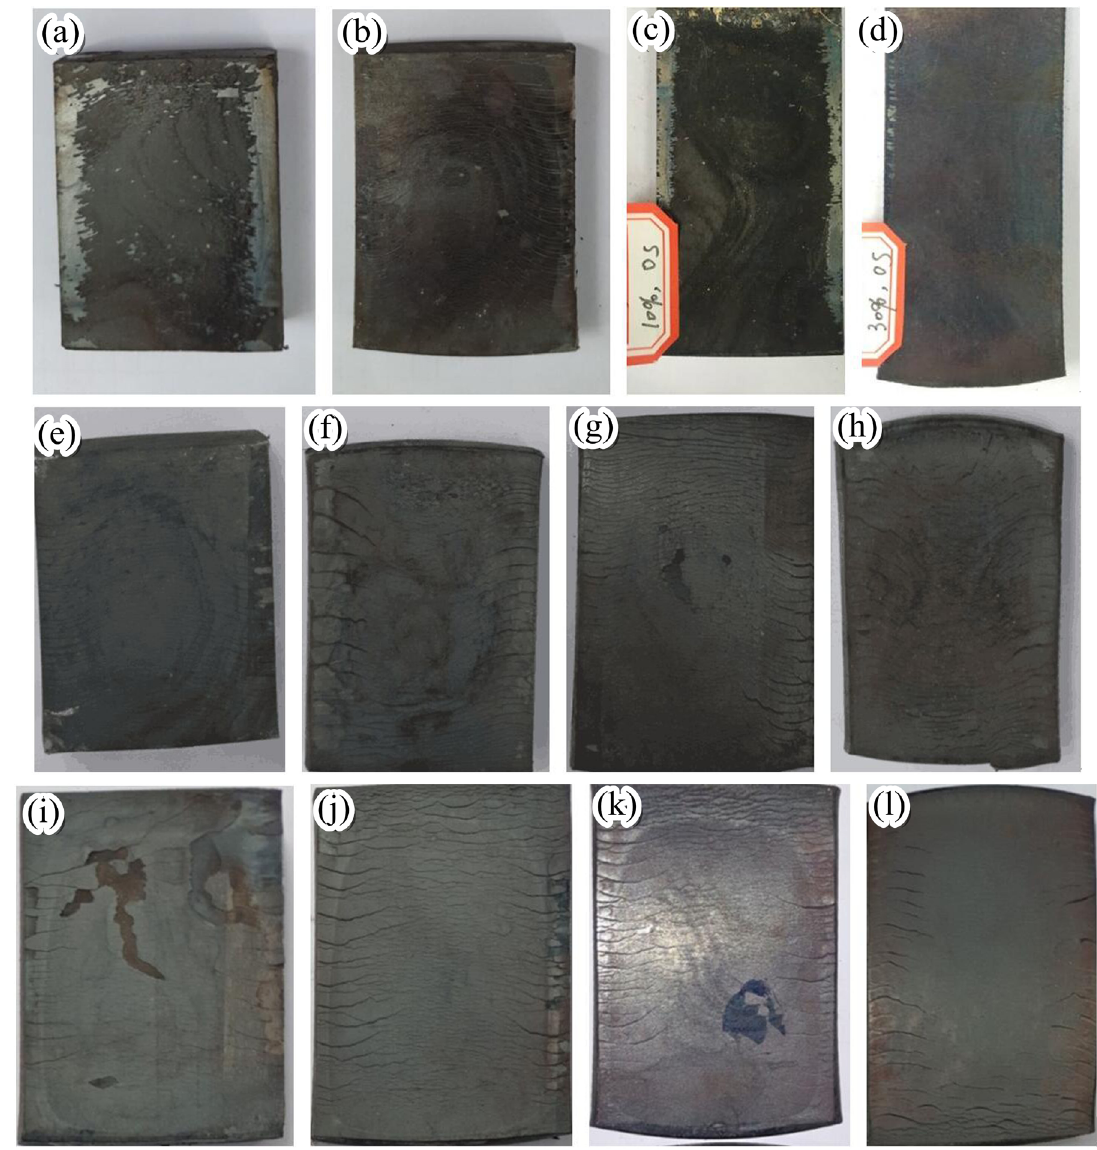
Figure 3. Surface morphology of oxide scale of samples after rolling. (a) 850°C-300s-5%; (b) 850°C-300s-20%; (c) 900°C-0s-10%; (d) 900°C-0s-30%. (e) 950°C-60s-10%; (f) 950°C-60s-20%; (g) 950°C-60s-30%; (h) 950°C-60s-40%. (i) 1000°C-6s-10%; (j) 1000°C-6s-